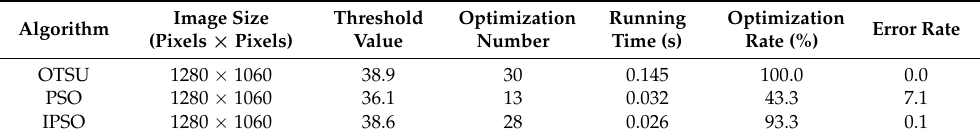
Figure 7. Output images of segmentation using different algorithms: ( a1 , b1 ) Original images collected by sensor; ( a2 , b2 ) Segmentation images using traditional OTSU algorithm; ( a3 , b3 ) Segmentation images using PSO algorithm; ( a4 , b4 ) Segmentation images using IPSO algorithm. Table 1. Comparison of performance parameters using different segmentation